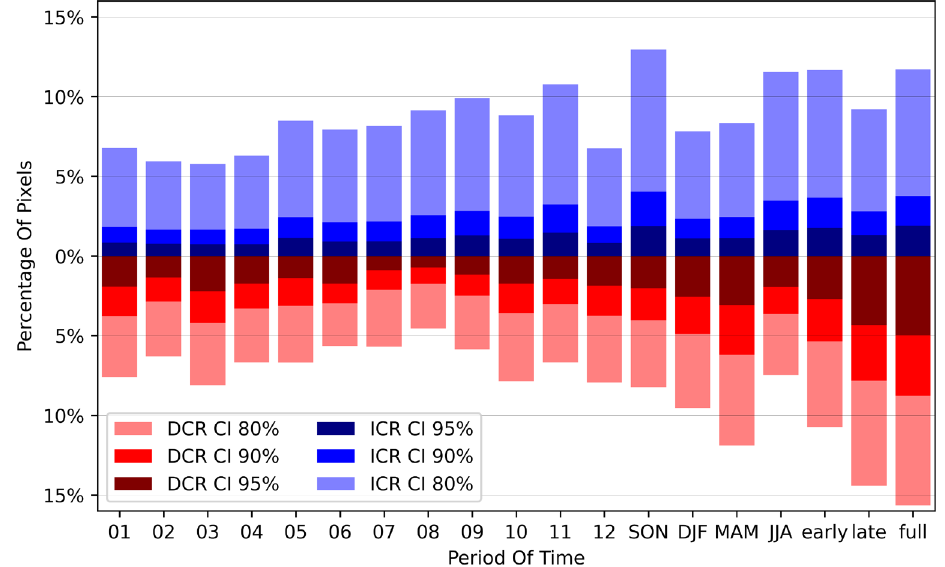
Figure 5. Overview of the results of the pixel-based trend analyses. The number of pixels (percentage of all 371 Mio. Pixels) are shown that have a significant trend in the confidence intervals (CI) 80%, 90% and 95%. The decreasing (DCR) developments of the SCD are shown in red, the increasing (ICR) developments are shown in blue.